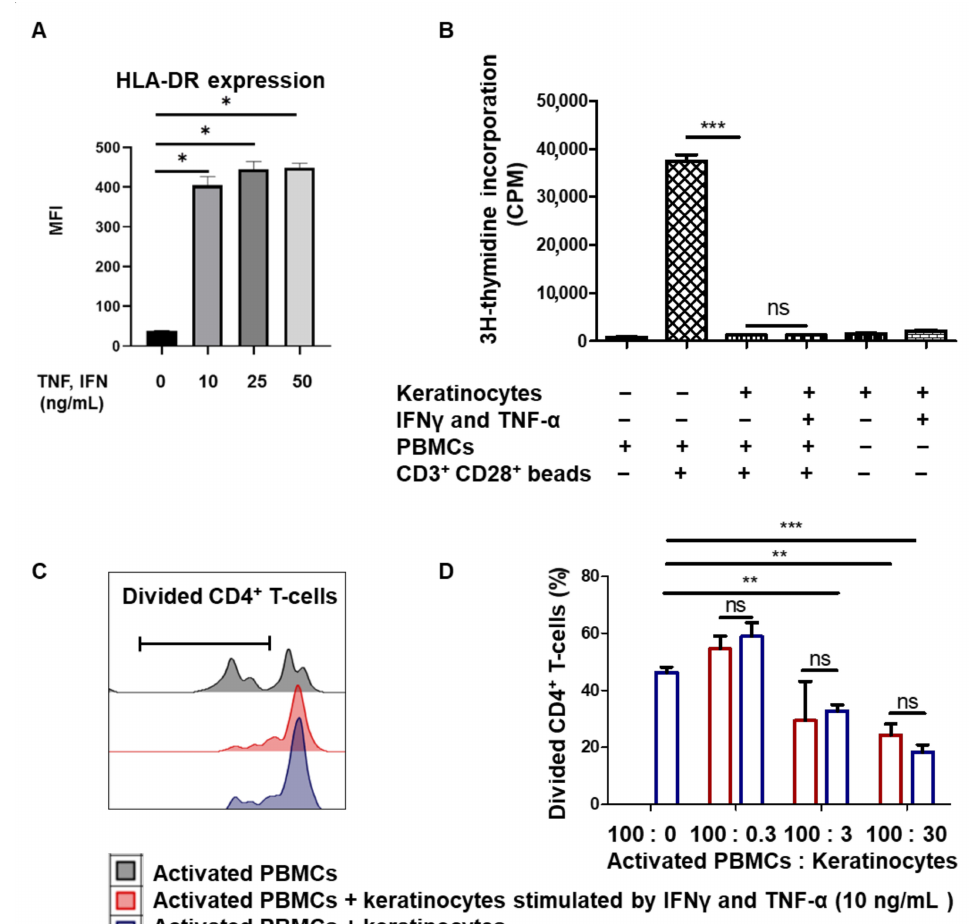
Figure 2. Amplified keratinocytes limit CD4 + T-cell proliferation whether they are in inflammatory conditions or not. ( A ) Cells from one representative donor were cultured for 2 days with IFN γ and TNF- α . HLA-DR expression was analyzed by flow cytometry (mean + SEM, p < 0.05, n = 4; Mann–Whitney U-test). ( B ) In total, 20,000 keratinocytes from 1 representative donor, stimulated or not by 10 ng/mL IFN γ and TNF- α for 2 days, were incubated or not with 100,000 PBMCs for 5 days. PBMCs activated by CD3 + CD28 + beads were used as positive controls. PBMC proliferation was quantified by thymidine incorporation at day 5 (mean + SEM, p < 0.05, n = 3). ( C , D ) Keratinocytes stimulated or not by 10 ng/mL IFN γ and TNF- α for 2 days were incubated with 100,000 PBMCs for 7 days. PBMCs were activated by CD3 + CD28 + beads. PBMC proliferation was quantified by dye decrease at day 7. ( C ) Representative flow cytometry profiles at day 7. ( D ) CD4 + T-cell proliferation according to inflammatory conditions (mean + SEM, p < 0.05, n = 3). Exact p-values were determined using the t -test. *: p < 0.05 and **: p < 0.01 and ***: p <